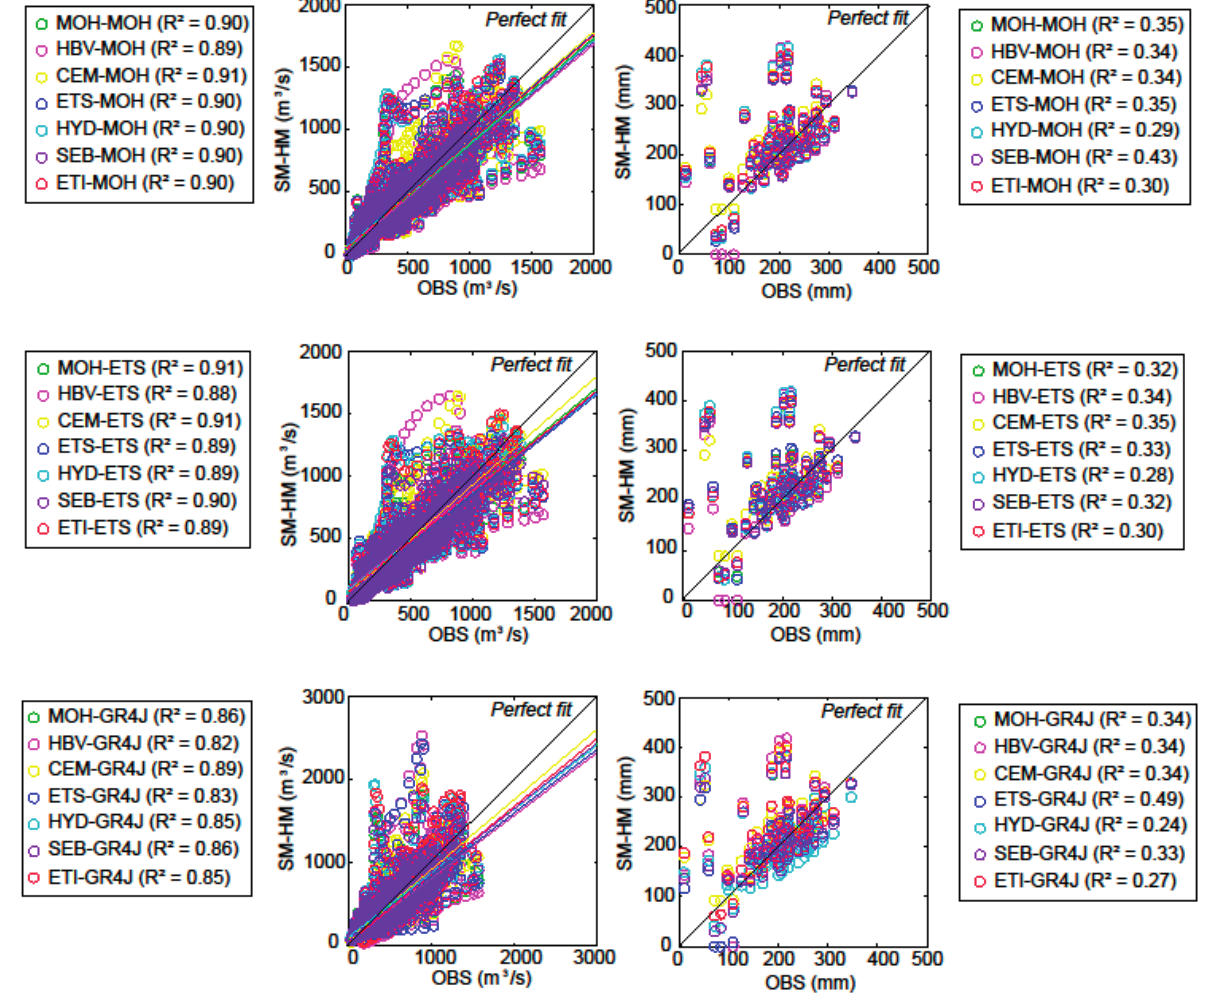
Figure 7. Scatterplots of observed, simulated daily discharges and SWEs with the 21 SM-HM combinations during the calibration period (even years over 1961–2000). The coefficient of determination ( R 2 ) obtained for each SM-HM is also